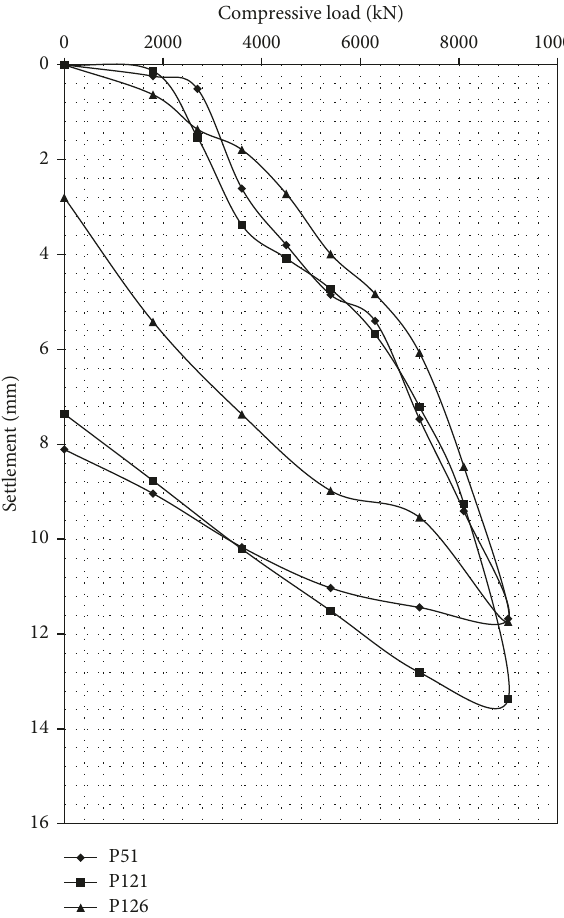
Figure 6: Results of compressive static load tests.